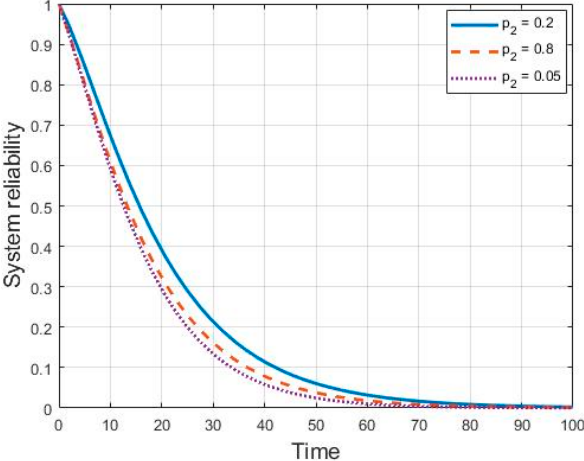
Figure 12. System reliability comparison with the changes of probability ( p 2 ) of fixing partial failures through software.